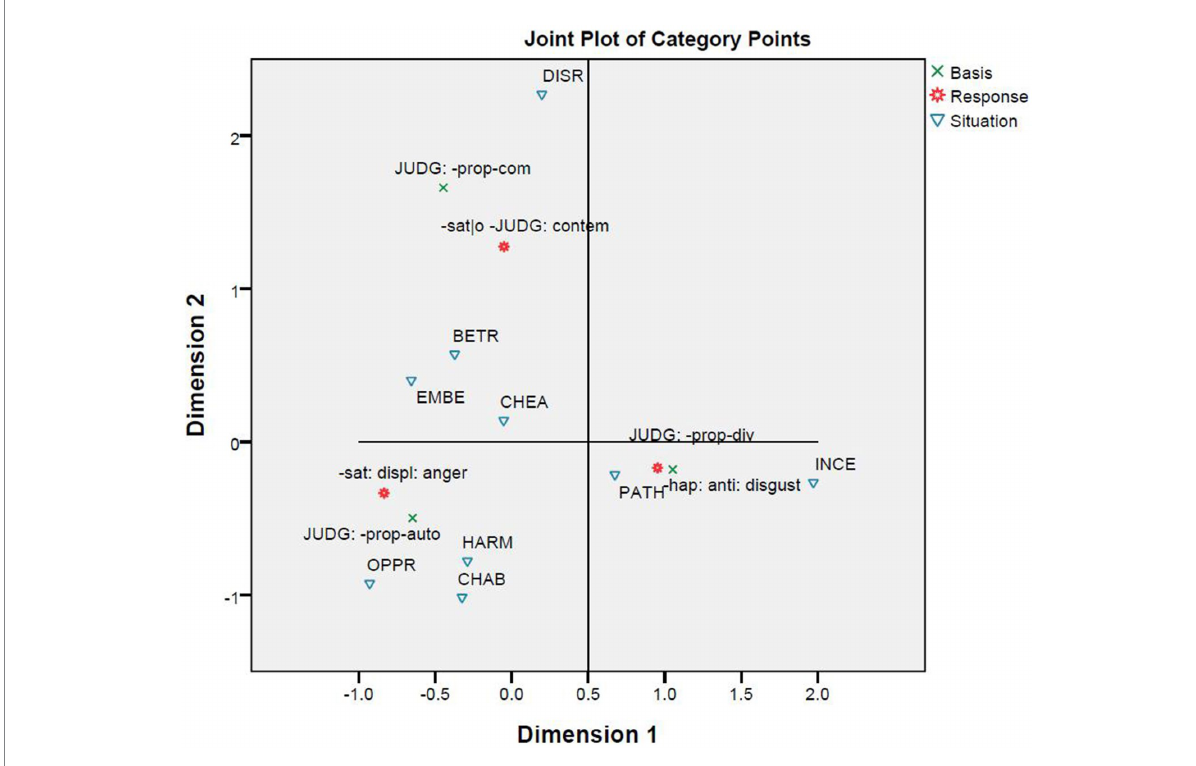
FIGURE 9 Correspondence analysis among basis, response and